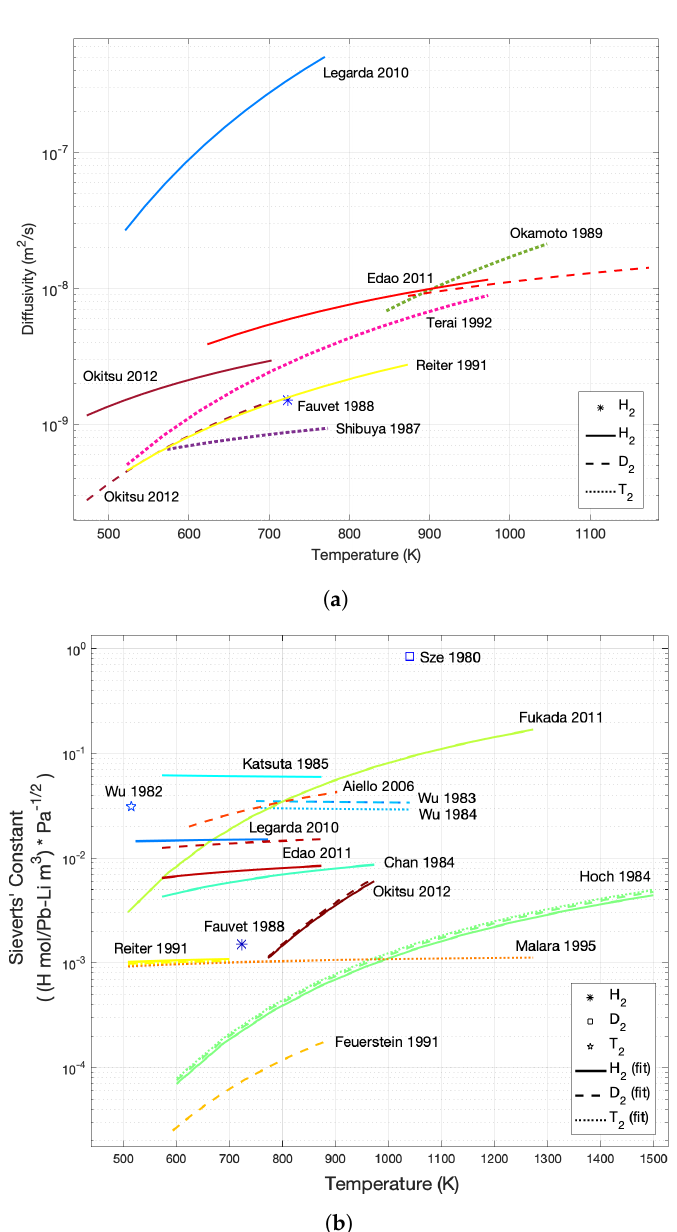
Figure 2. Literature review of D Pb-Li and S Pb-Li . If only point values were available in any Q Q 2 given reference, dissolution parameters were obtained by logarithmic regression after applying unit transformation. ( a ) Literature values and functions of diffusivity for hydrogen isotopes in Pb-Li [10,18–24]. ( b ) Literature values and functions of Sieverts’ constant for hydrogen isotopes dissolution in Pb-Li [11,18,20,22–35]. When necessary, the temperature-dependent density of Pb-Li was used for unit conversion